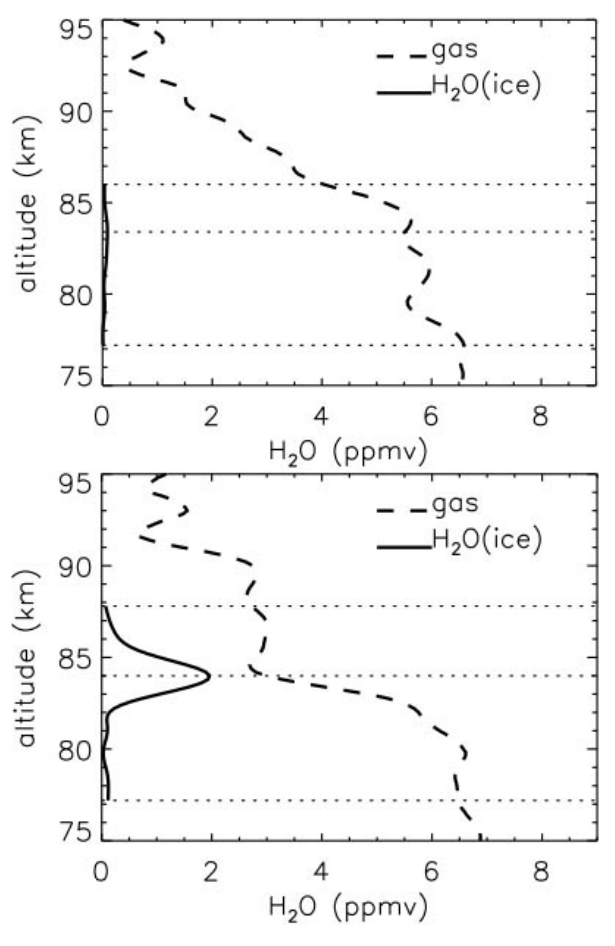
Fig. 13. SOFIE observations on 6 August 2007 nearest to the MASS2 flight, 21:02UTC at 72.0 ◦ N, 22.6 ◦ E (top graph) and 22:39UTC, at 72.0 ◦ N, 358.4 ◦ E (bottom graph). Horizontal dot- ted lines indicate Z top , Z max , and Z bot determined from H 2